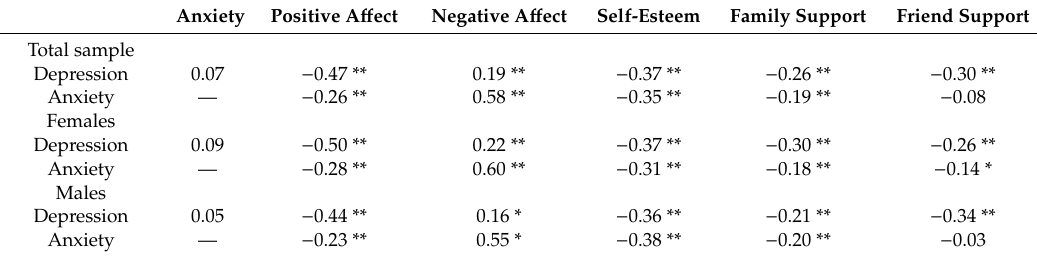
Table 2. Spearman correlation coe ffi cients between (1) depression and anxiety and (2) a ff ectivity, self-esteem, and social support ( n = 467).